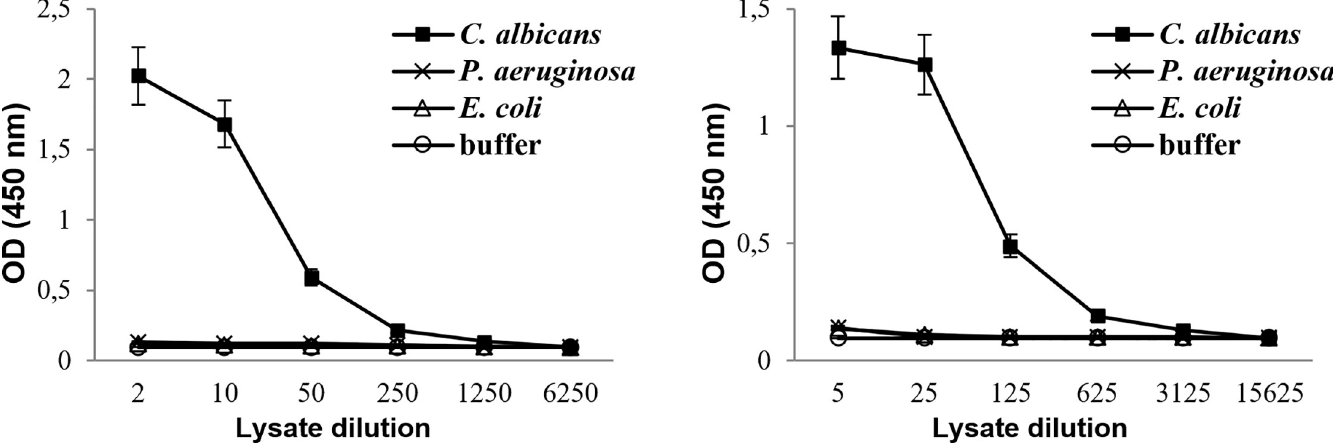
Fig 5. Binding of fungal and bacterial cell lysates with mAbs 3G11 and 5H5. Sandwich enzyme-linked immunosorbent assay (ELISA) with anti- G9 antibodies: the wells of microtiter plates were coated with 200 ng mAb 3G11 ( A ) or mAb 5H5 ( B ) and incubated with serially diluted sonicated suspension of indicated microbial cultures; ELISA was performed with horseradish peroxidase-conjugated mAb 5H5.